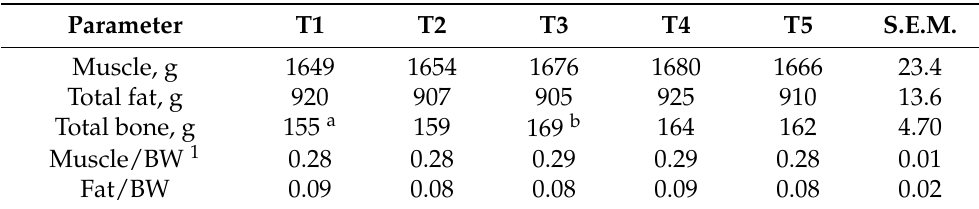
Table 3. Predicted least square means of carcass composition of broiler chickens at 42 days of age fed different levels of Black Soldier Fly larvae (BSFL). T1